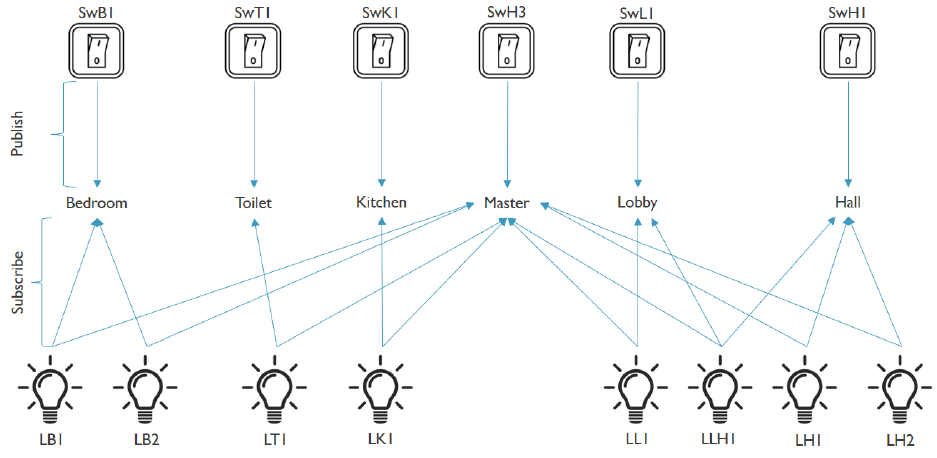
Figure 4. Publish–subscribe mechanism of communication in BLE